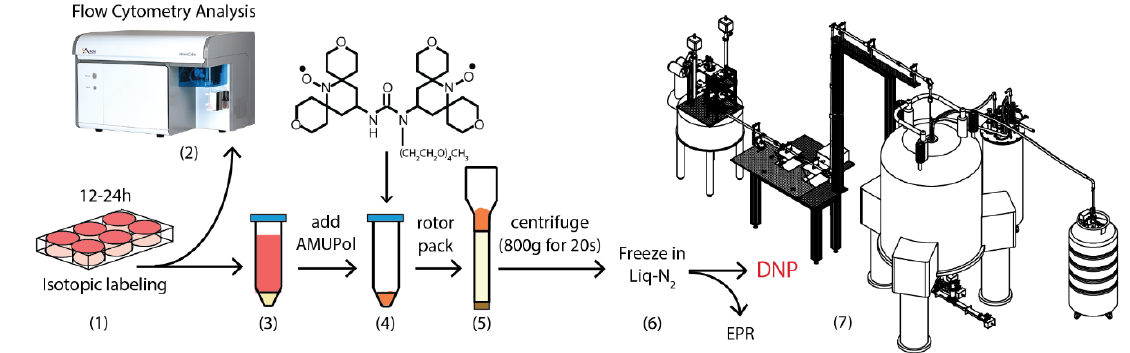
Figure 1. Preparation of the Jurkat T cells for dynamic nuclear polarization (DNP)-NMR. (1) Jurkat T cells are cultured for 12–24 h in isotopically labeled by the complete Roswell Park Memorial Institute (cRPMI). (2) A small aliquot of cells is taken for flow cytometric analysis. (3) The rest are pelleted by centrifugation and washed with phosphate buffered saline. (4) AMUPol and cryoprotectant are added directly to the cell pellet. (5) The cells are centrifuged for 20 s into a 3.2 mm ZrO 2 rotor or electron paramagnetic resonance (EPR) tube. (6) Packed rotors or EPR tubes are immediately frozen in liquid nitrogen. (7) DNP solid-state NMR and EPR analysis of Jurkat cells is then carried out. See Materials and Methods for additional details.